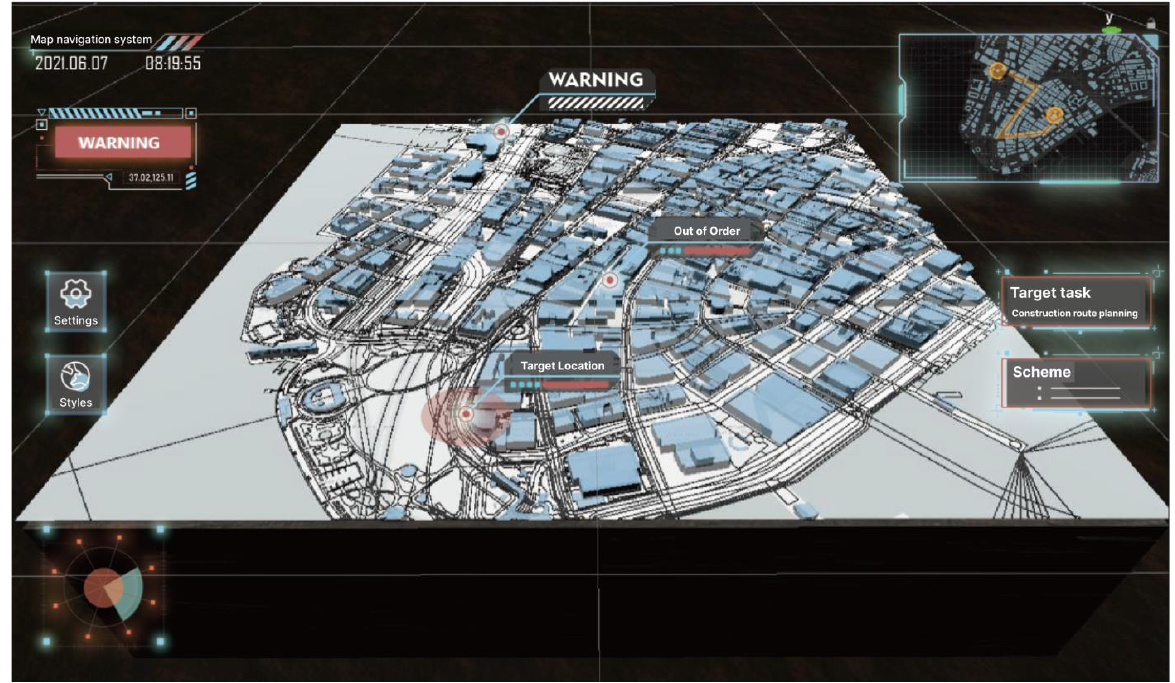
Figure 4. The VR map navigation system demo scene.